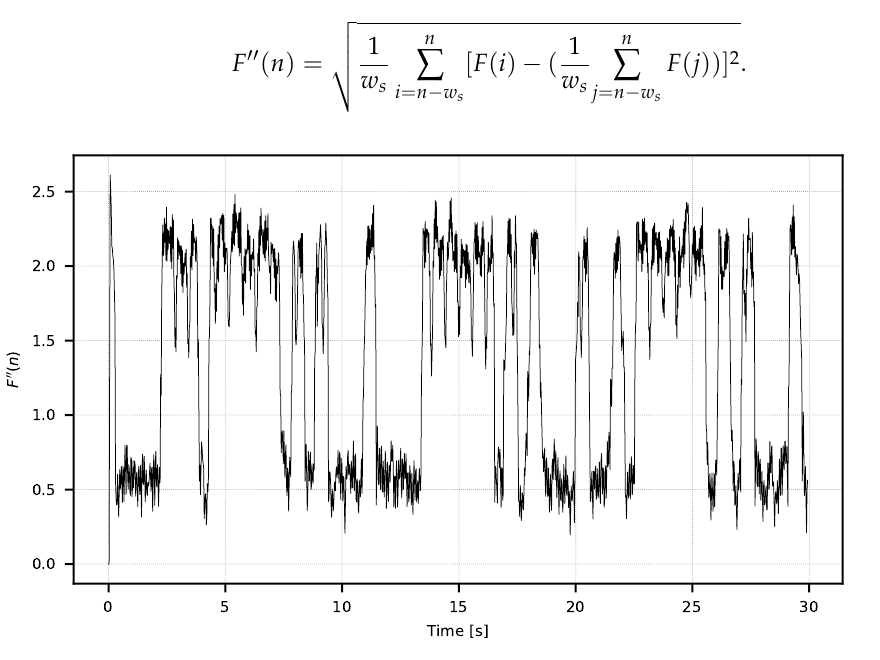
Figure 11. Signal F (cid:48)(cid:48) (6) calculated with w s = 5.